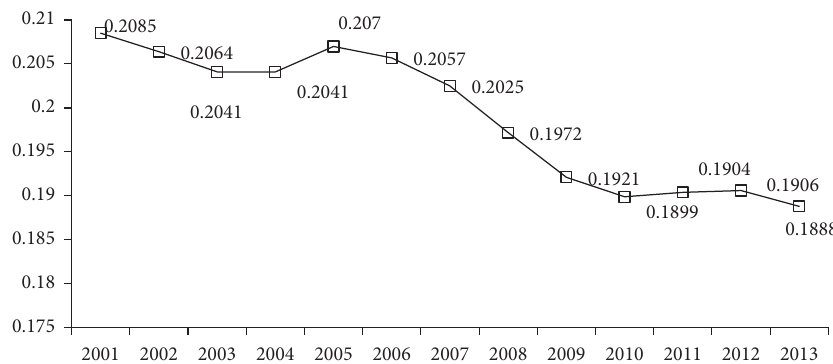
Figure 6: Evolution of entropy for